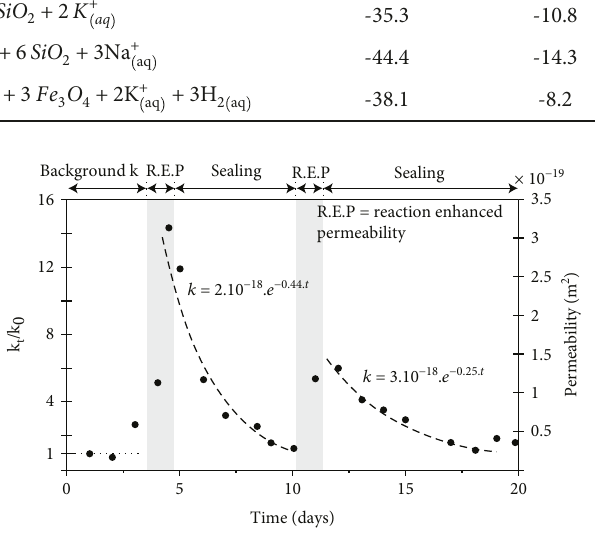
Figure 8: Evolution of permeability over time during the greisenization experiment. This time evolution depicts cycles of permeability increase followed by stages of gradual decrease that may, respectively, be attributed to porosity generation during the replacement reactions and sealing by closing of the neoformed pathways. The stages of permeability decrease fi t with exponential functions commonly observed in experimental